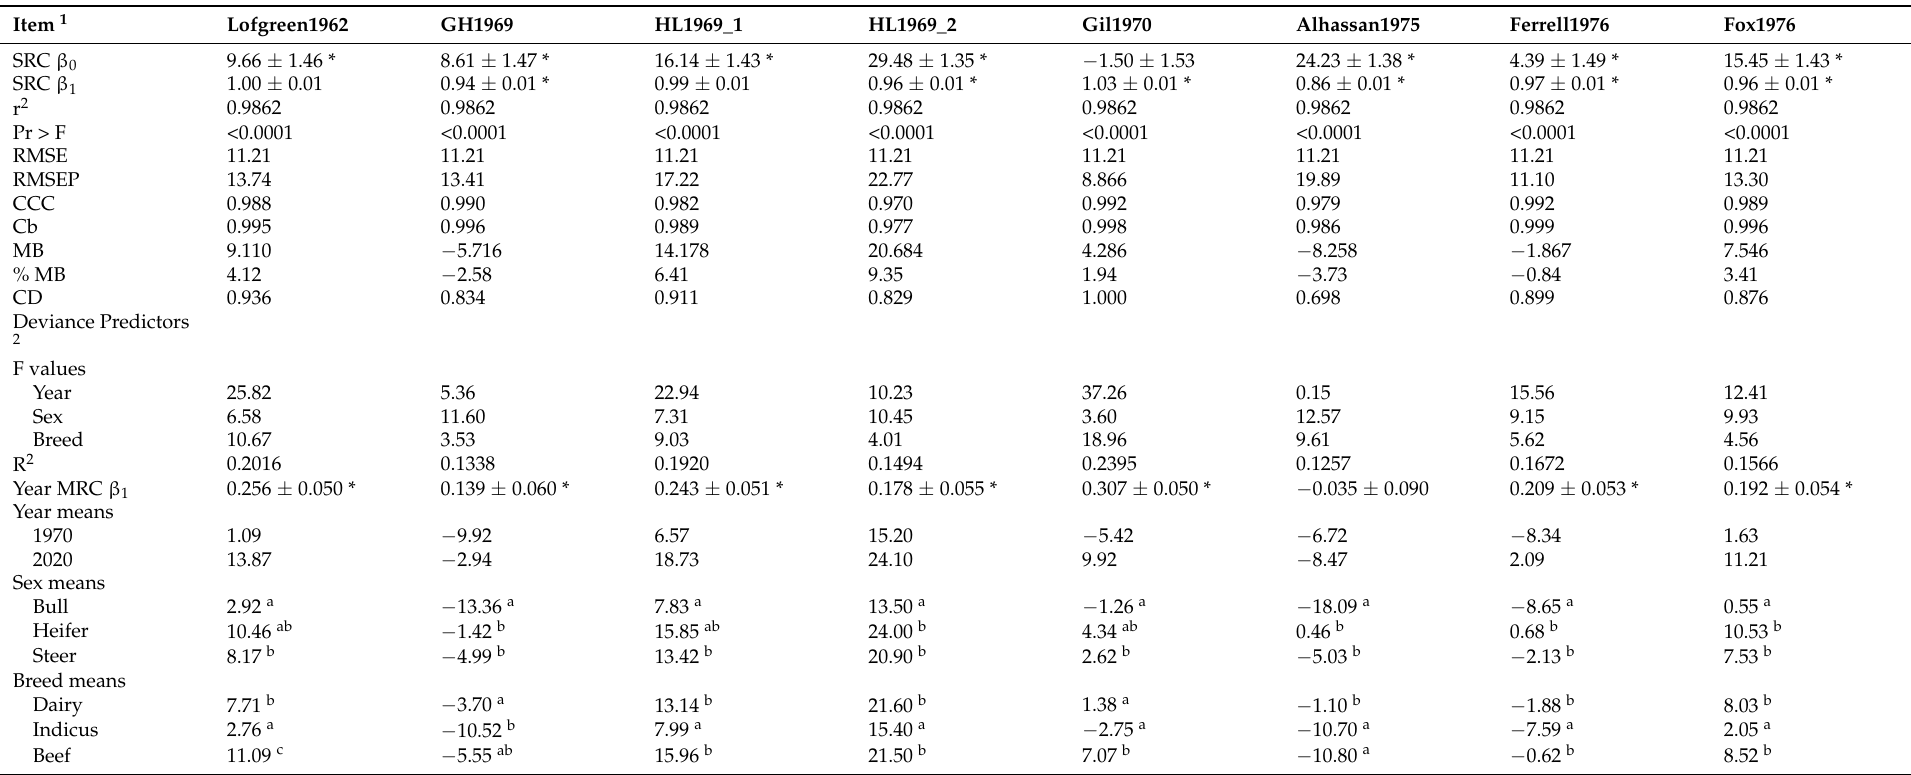
Table 3. Model evaluation of equations predicting carcass weight computed from empty body weight, and predictive variables of the deviance between observed and predicted carcass weight in the Weight